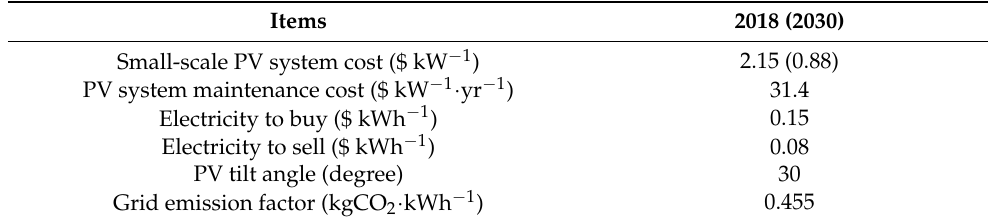
Table 1. Parameters used for techno-economic analyses [5]. Small-scale PV system costs are for 2018 (2030), respectively. Maintenance costs for PV system include inverter